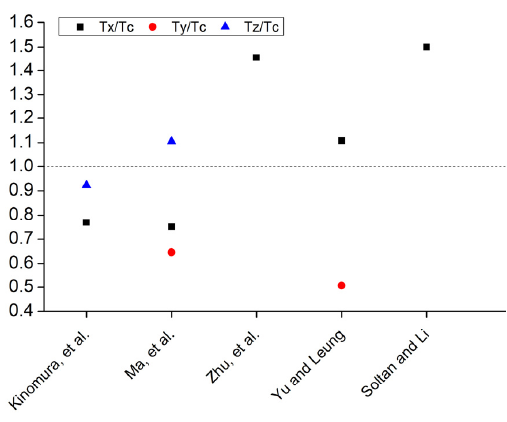
Figure 12. Anisotropy in tensile strength of 3D-printed concrete at different axes with respect to the printing direction [49,61,127,182,186].